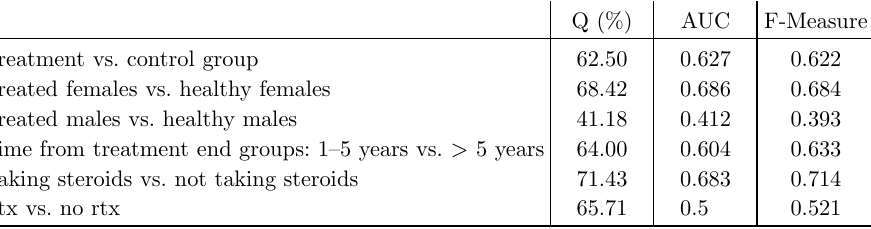
Table 10. Classification results; Q – accuracy; AUC – area under ROC curve;